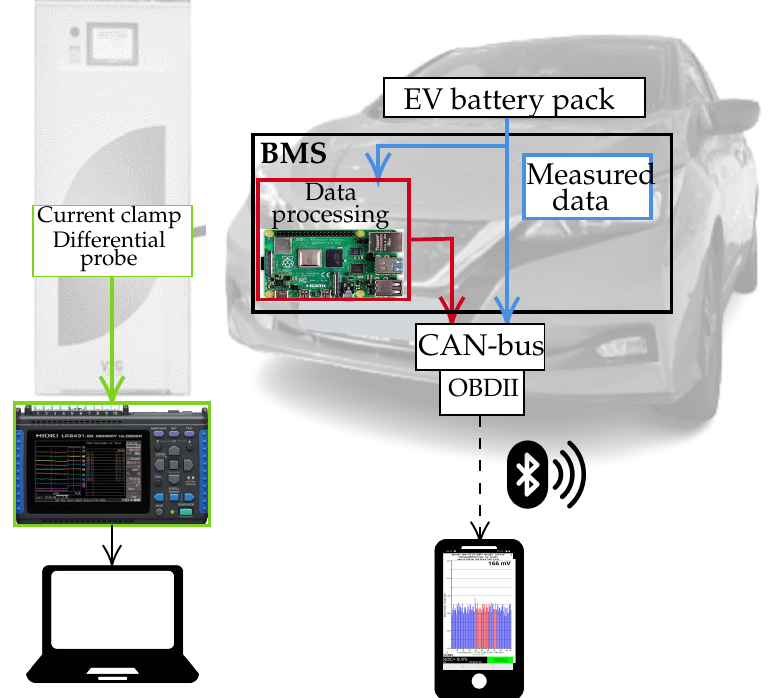
Figure 1. Data collection overview. On the left, current and voltage measurements are collected from the DC charger with current clamp, differential probe, and datalogger. On the right, raw measurements (in blue) are collected from the BMS and CAN-bus, together with estimations derived by the EV